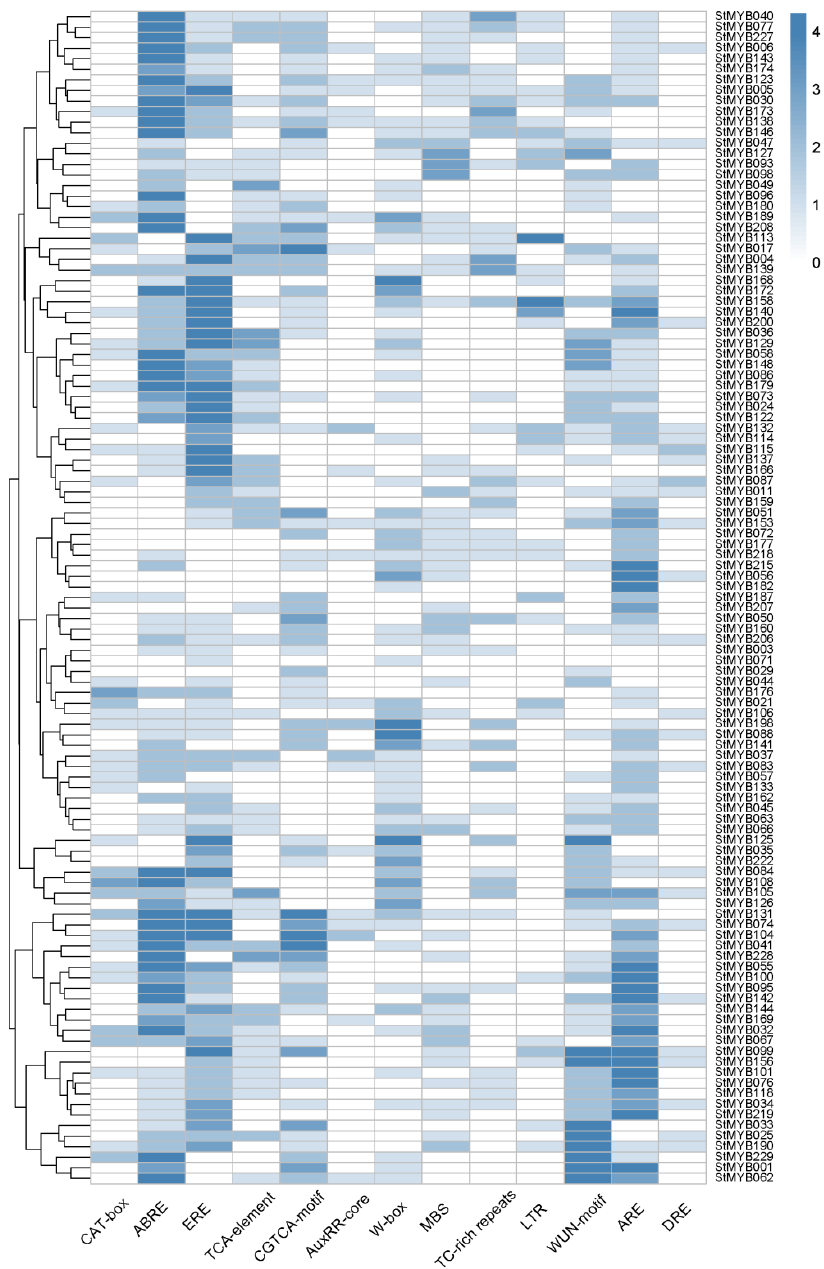
Figure 6. Regulatory elements in the promoter regions of StMYB genes.